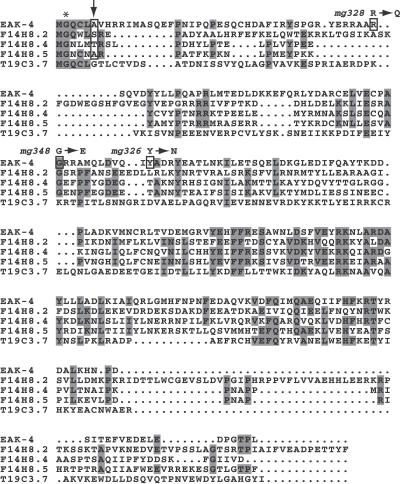
EAK-4 Amino Acid Sequence and Alignment with Four C. elegans HomologsSequences represent the entire predicted amino acid sequences of all five genes. EAK-4 sequence was derived from full-length cDNA amplified by RT-PCR from wild-type C. elegans total RNA. Alignment was constructed using ClustalX 1.8 and MacBoxshade 2.15. Shaded residues indicate amino acid identity and conservation. Mutated residues in three alleles of eak-4 are boxed, and the predicted amino acid change is indicated above the box. The conserved G at residue 2 and S/T/A (boxed) at residue 6 in the N-myristoylation consensus sequence [70] are denoted by an asterisk and a vertical arrow, respectively.